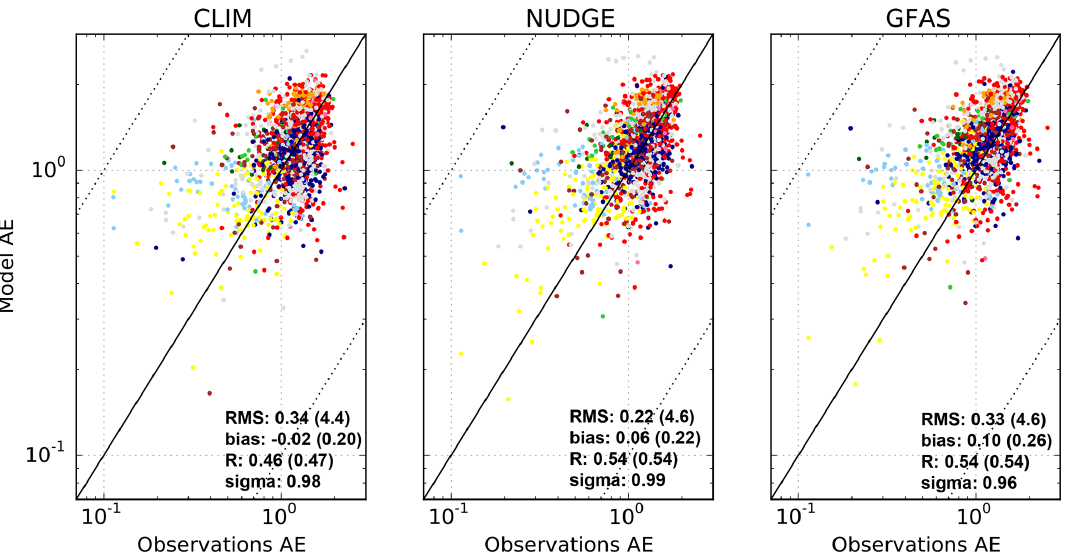
Figure 6. Scatterplot of observed versus simulated mean Ångstrom exponents over the period January 2003 to December 2012 at the AERONET stations shown in Fig. 1 for the CLIM, NUDGE, and GFAS simulations. The color coding of the results is as in Fig. 5, and the simulated means and statistical parameters are constructed and calculated, respectively, as in Fig. 5.